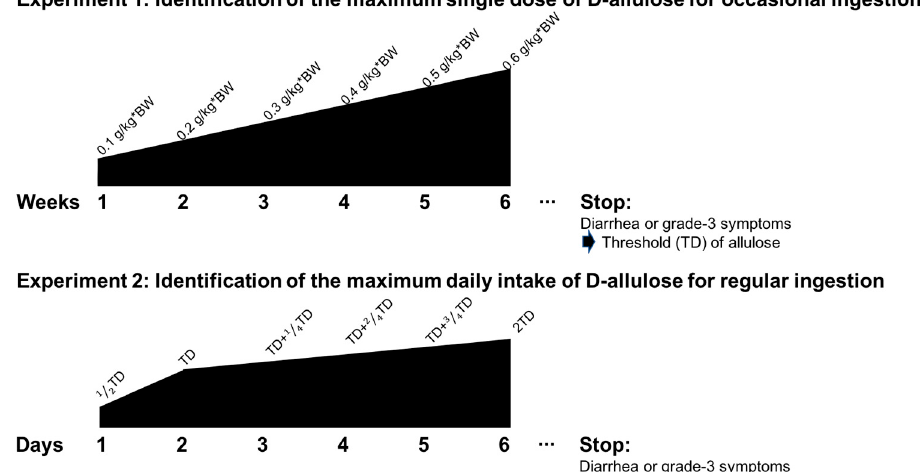
Figure 1. Experimental design of the D-allulose tolerance test to determine the maximum single dose and daily maximum intake.